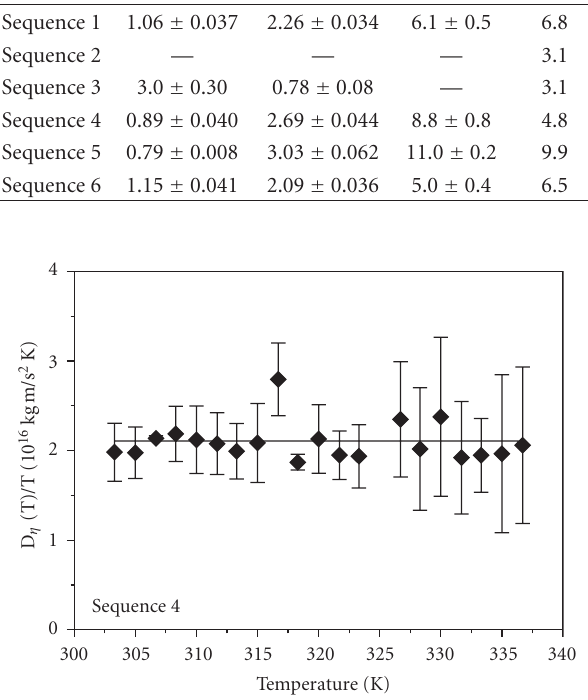
Figure 5: The values of the di ff usion coe ffi cient of the fast mode D f normalised by solution temperature T and solvent viscosity η ( T ) show no modifications with temperature. This suggests that the associated quadruplex structure is stable in the whole investigated temperature